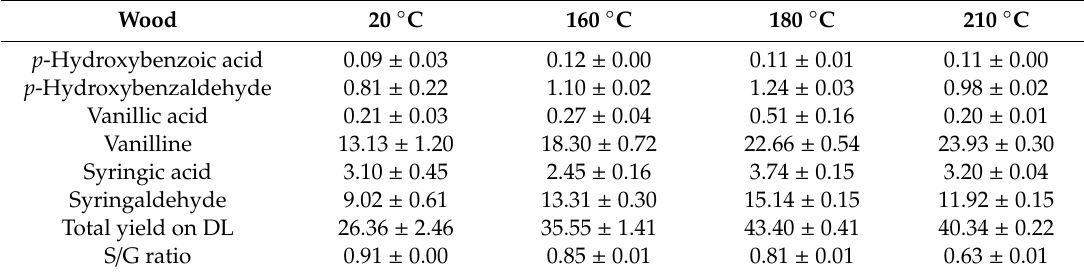
Table 2. Nitrobenzene oxidation products of teak dioxane lignins (mean ± SD, %).